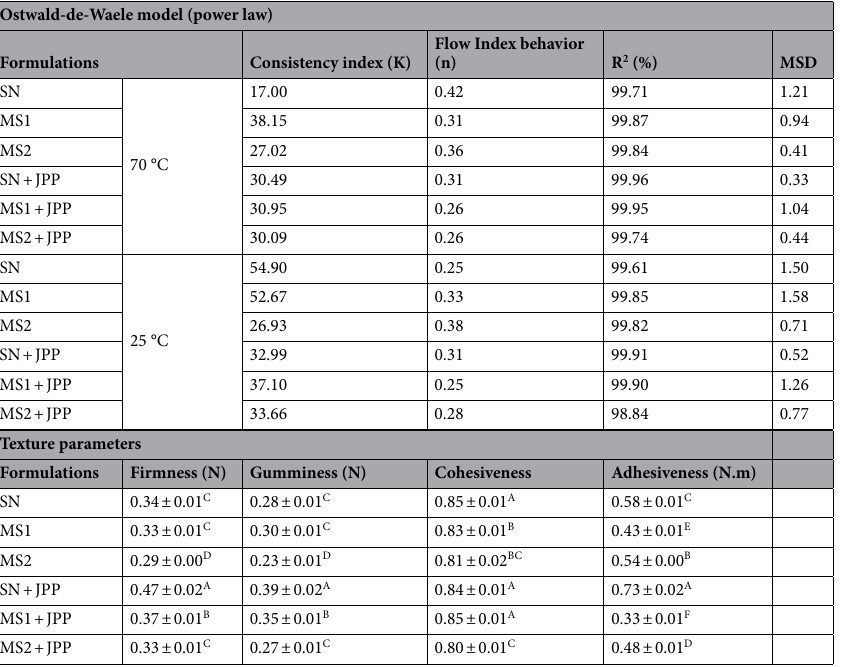
Table 3. Regressed coefficients for Ostwald-de-Waele model (Power Law) and texture parameters at 25 °C. Equal overlapping capital letters in the same column did not differ significantly between the formulations studied ( p > 0.05). SN native starch, MS1 Modified starch by α-amylase, MS2 Modified starch by α-amylase and amyloglucosidase, JPP jaboticaba peel powder, MSD mean square